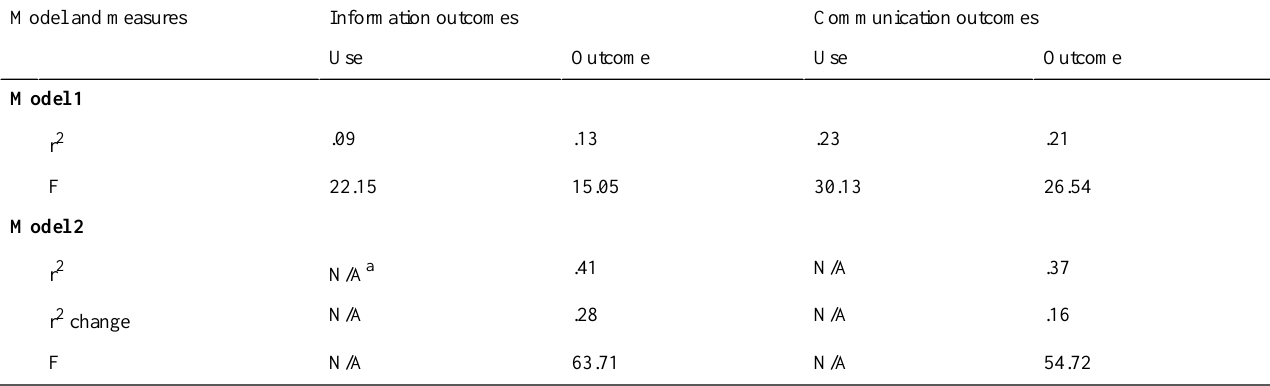
Table 6. Changes in the significance of the determinants after internet uses were added to the models ( P <.001).